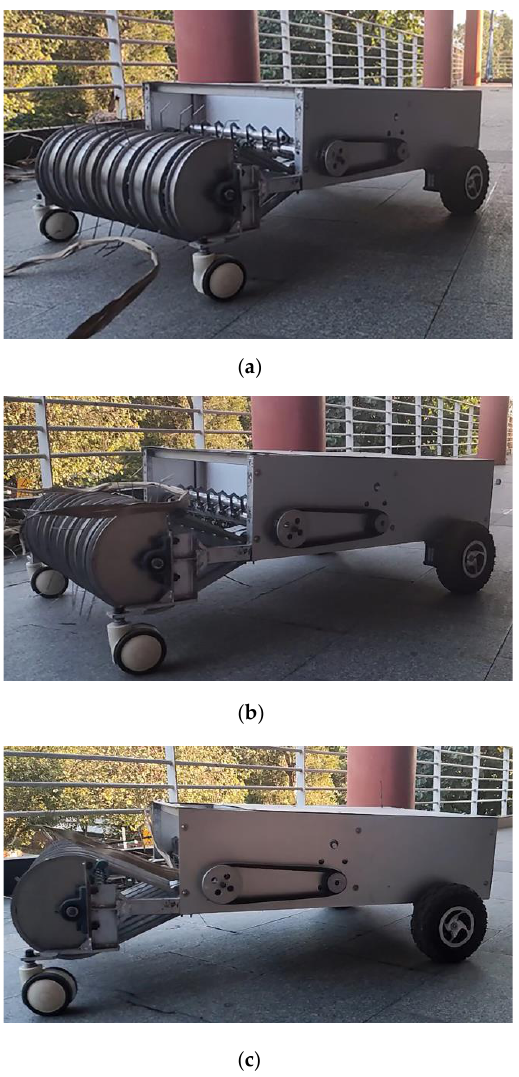
Figure 16. Quick camera experiment of sugarcane leaf-picking process. (a) represents the situation for the experiment at 0.2325 s, (b) represents the situation for the experiment at 1.0695 s, and (c) represents the situation for the experiment at 1.86 s.